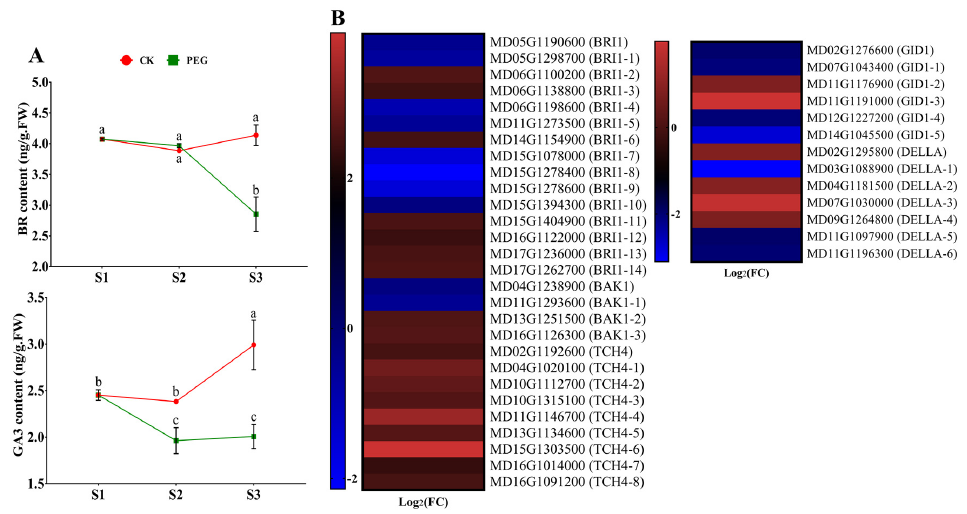
Figure 6. Effect of a polyethylene glycol (PEG) treatment on the endogenous content of brassinolide (BR) and gibberellic acid 3 (GA3) over the course of this study (S1, S2, and S3) during adventitious root (AR) formation in GL-3 apple cuttings when compared to a PEG-free control (CK) group. Error bars refer to the average value ± SD from three biological replicates. Different letters indicate significant differences by least significant difference (LSD) test at p ≤ 0.05 ( A ). Selected differentially expressed genes (DEGs) related to BR and GA from RNA sequencing data (only at S2 of CK and PEG treatment). Heat map diagram of the log2FC, the red and blue colors specify up-and down-regulated expressions ( B ).